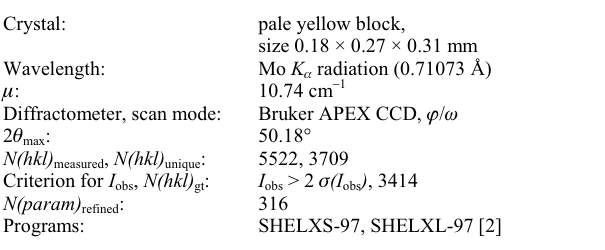
Table 1. Data collection and handling.